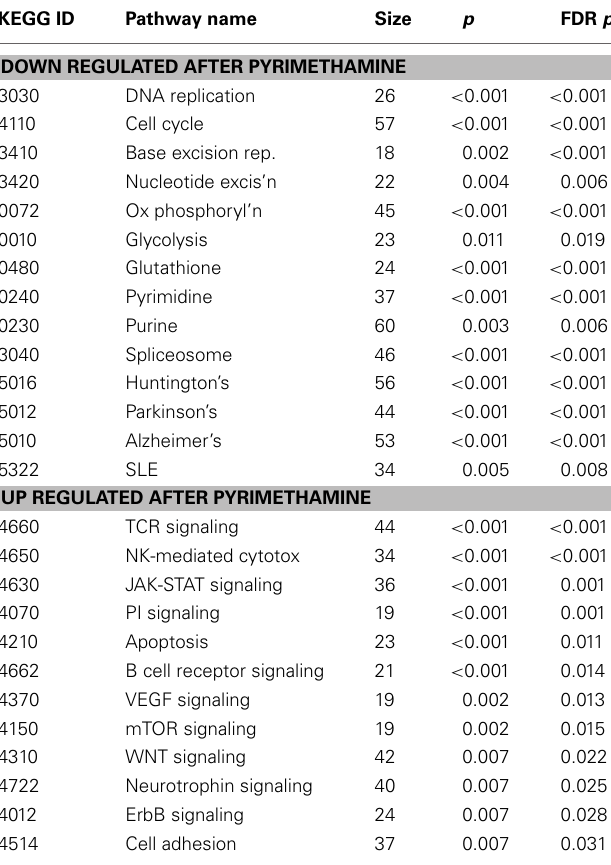
Table 4 | Gene set enrichment